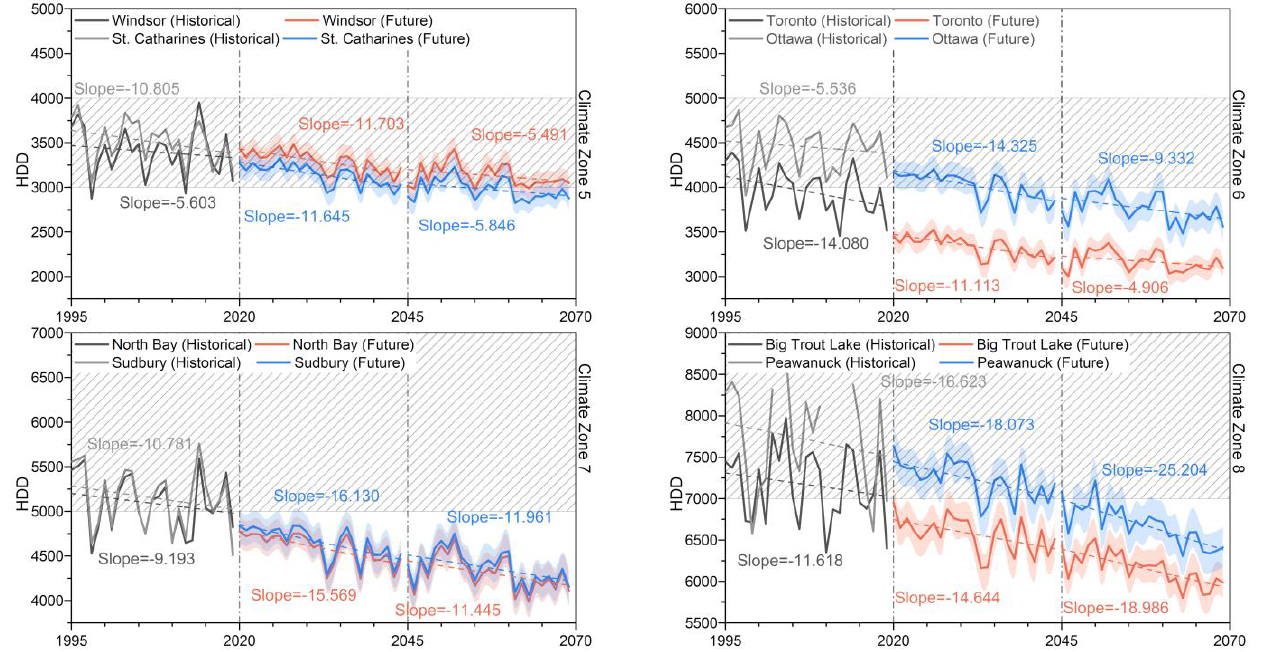
Figure 8. Historical (1995–2019) and future (2020–2069) annual HDD for climate zones.